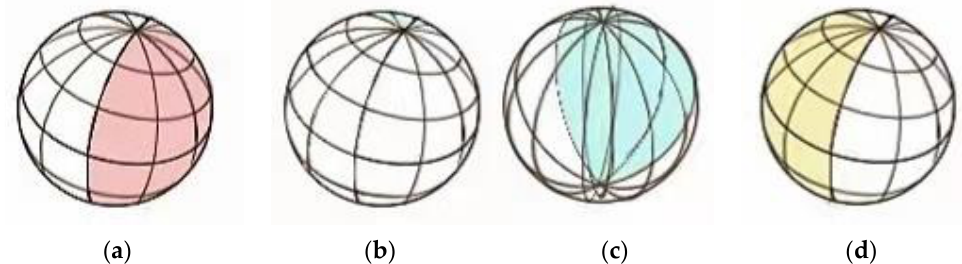
Figure 4. Schematic diagram of space division. ( a ) is the first sub-space, which ranges from 0 ◦ to 120 ◦ . ( b ) is the second sub-space, which ranges from 120 ◦ to 240 ◦ . ( c ) is a perspective view of ( b ). ( d ) is the third sub-space, which ranges from 240 ◦ to 360 ◦ .